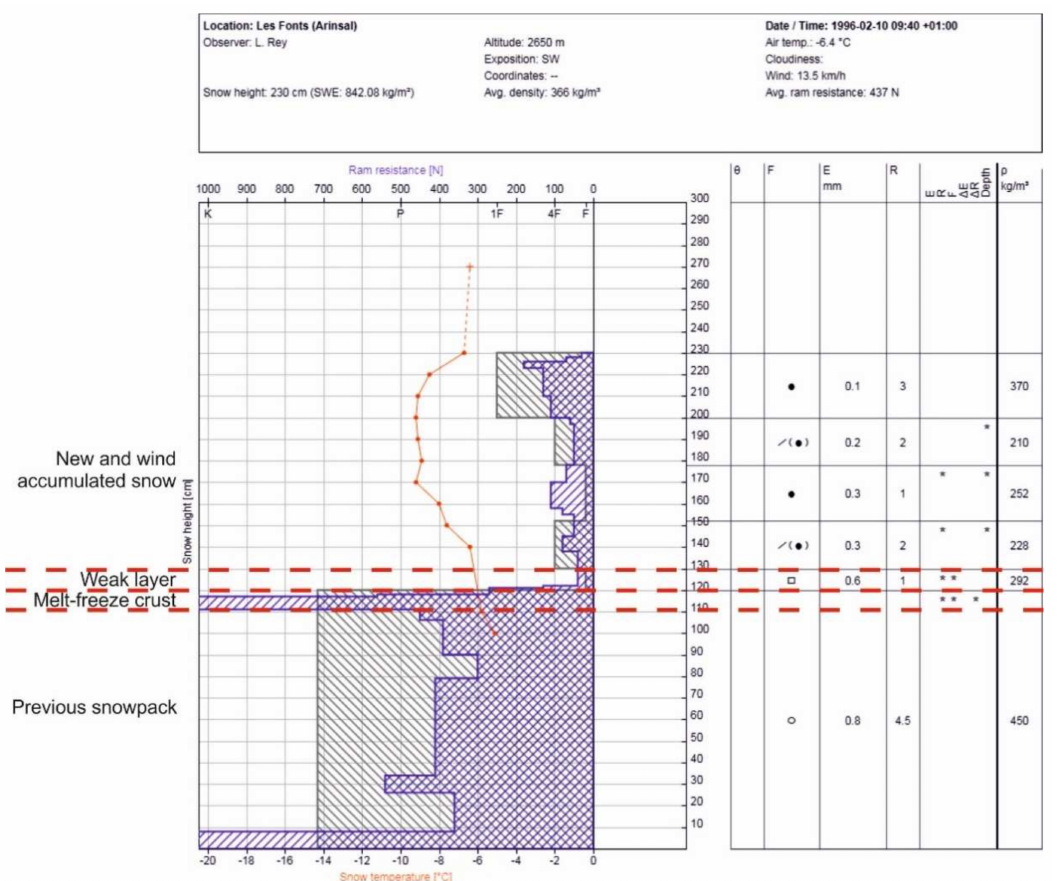
Figure 6. Snowpack profile made by Laurent Rey, accompanied by Margaret Bar ó , at 9:40 a.m on 10th February. See Figure 1 for